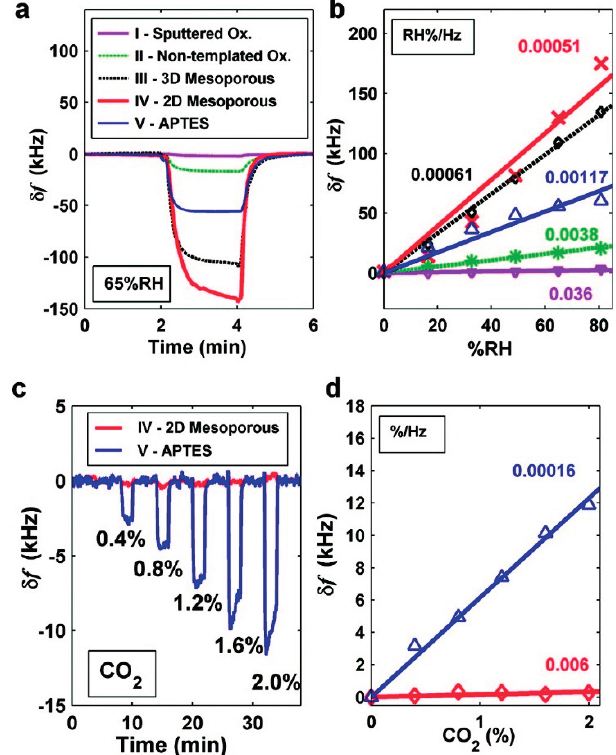
Figure 13. ( a ) Transient frequency shift values of the batch fabricated sensors in response to 65% relative humidity (RH) in N 2 ; ( b ) Summary of the maximum frequency-shift sensing signal observed at different RH values; ( c ) Transient frequency shift values of two sensors, number IV and V in (a), in response to various concentrations of CO 2 in N 2 ; ( d ) Plot of the maximum frequency-shift signals observed at different CO 2